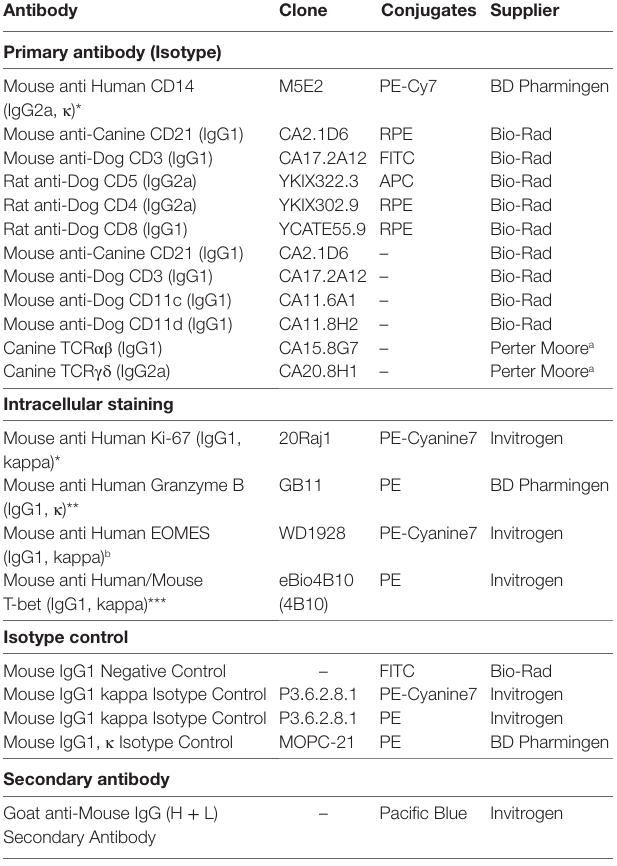
TaBle 1 | Antibodies used for flow cytometry in this study. antibody